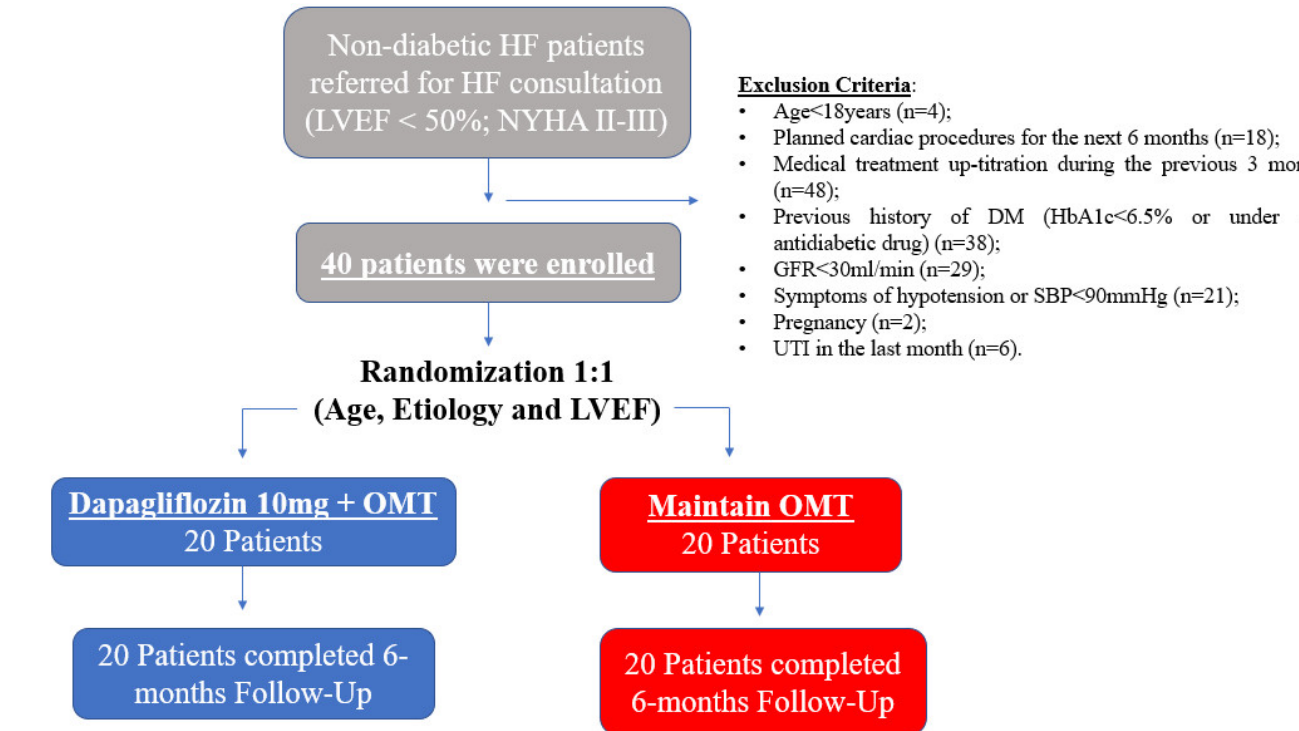
Figure 2. Primary endpoint—peak oxygen uptake variation from baseline to 6 months follow-up.